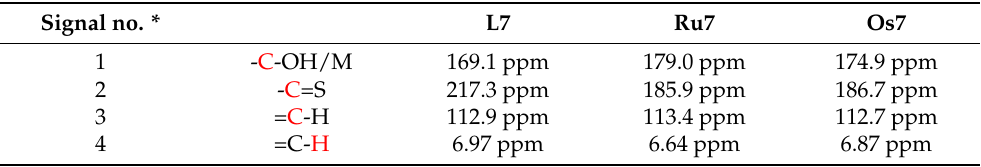
Table 1. Selected NMR signals for L7/Ru7/Os7. Ru and Os compounds show similar effects after complexation resulting in comparable NMR pattern and changes. A high field shift is observable for signals 2 and 4; a low field shift for signal 1 and signal 3 does not show remarkable changes. Signal no. * L7 Ru7